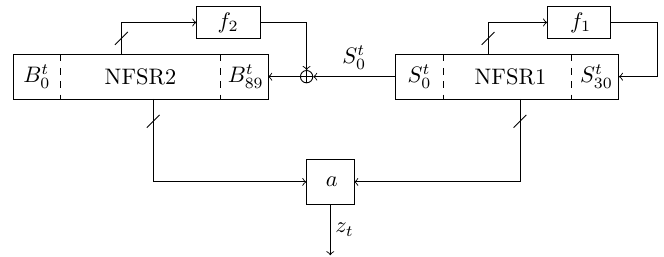
Figure 1: Lizard in keystream generation